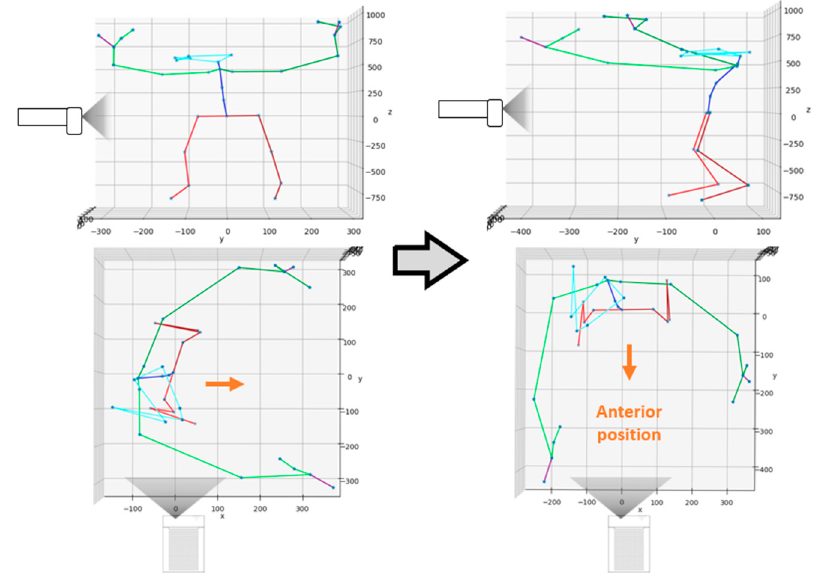
Figure 8. Step 4: Yaw rotation on skeleton to face on − Y direction (anatomically anterior position).